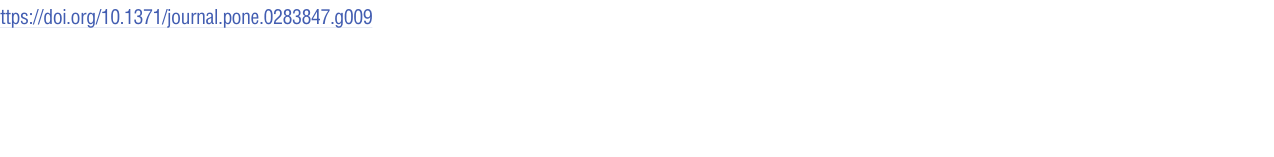
PLOS ONE | https://doi.org/10.1371/journal.pone.0283847 April 12, 2023 16 /